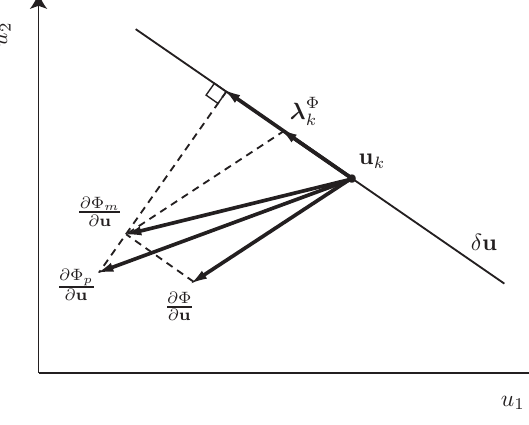
Figure 2. Matching the projected gradient of the plant using D-MA.